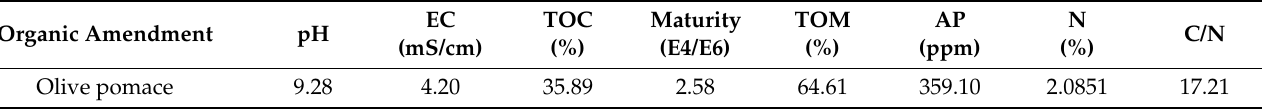
Table 2. Physico-chemical characteristics of the used